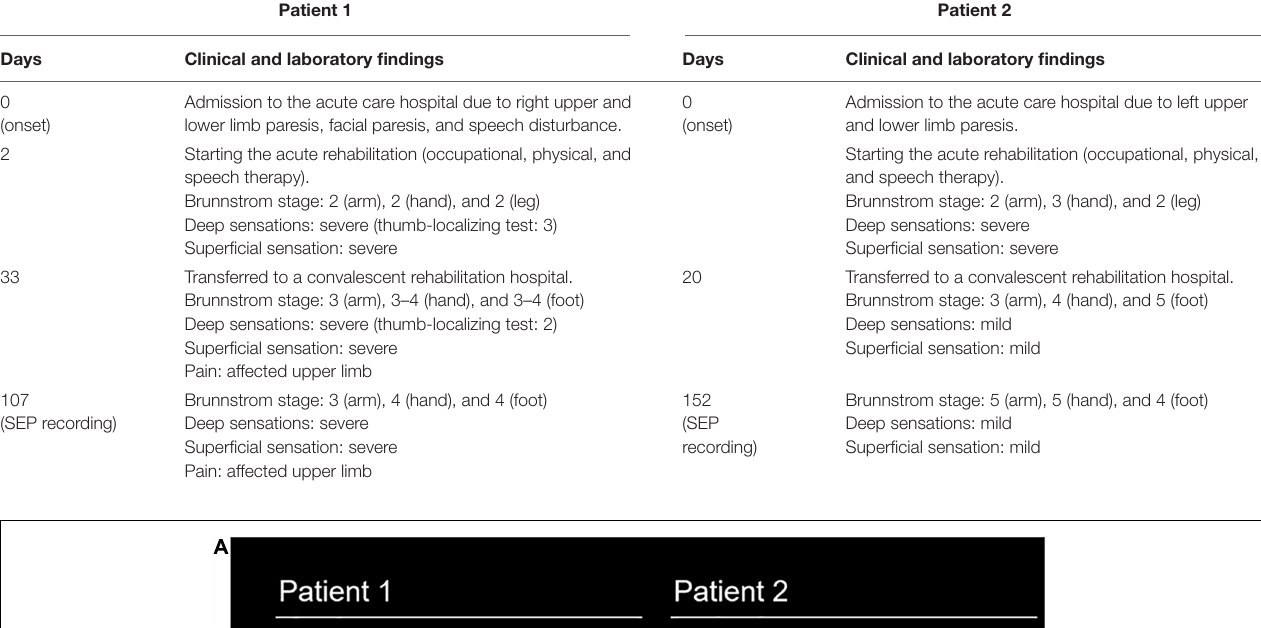
TABLE 1 | Clinical and laboratory findings on patients 1 and 2.